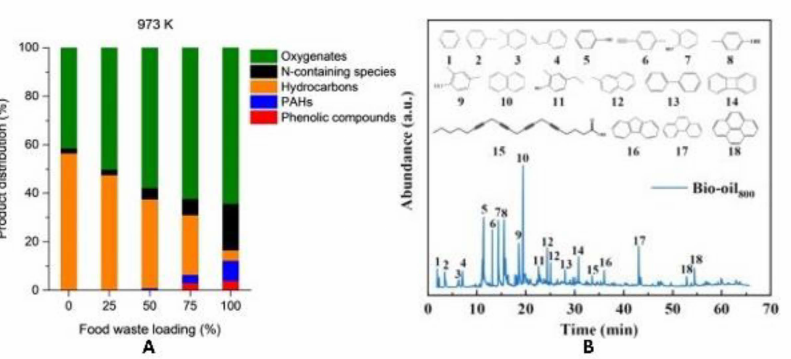
Figure 7. ( A ) Liquid product distributions from the co-pyrolysis of disposable masks and food waste at 973 K with various food waste loadings. Reproduced with permission from Ref. [53].